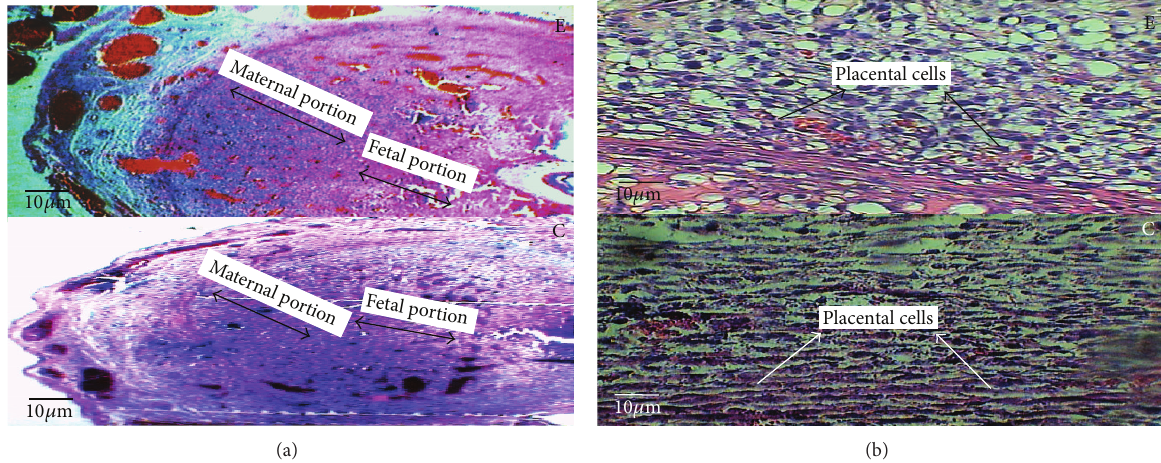
Figure 5: The microscopic image of the time-dependent effect of oral morphine consumption in the experimental (E) groups and the control (C) groups in the 9-day-old placenta with 40x magnification, (a) illustrating the thicknesses of both maternal and fetal portions of the placenta by the double-headed arrow. (b) The microscopic image of the experimental group and the control group in the 9-day old placenta with 40x magnification, illustrating the placental cells.